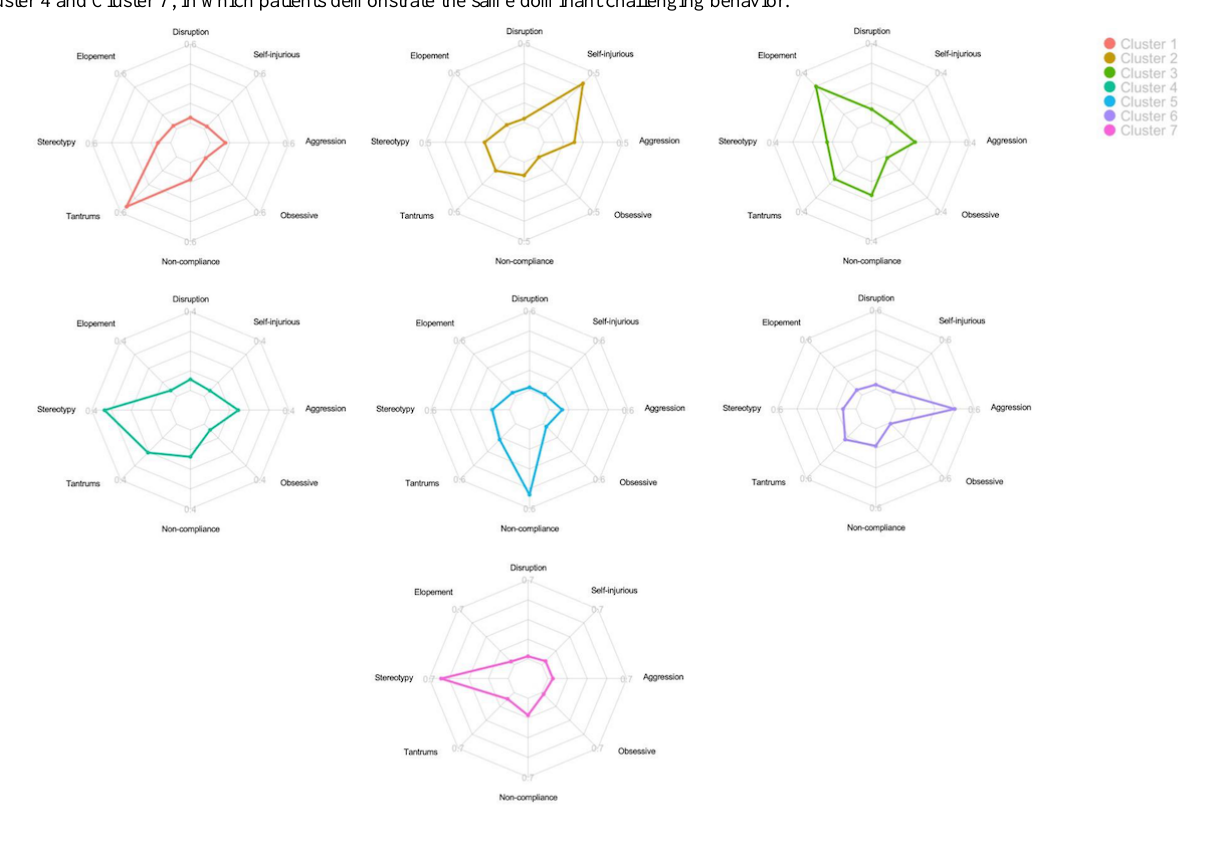
Figure 3. Radar graphs showing the dominant challenging behavior for each cluster. Note that the maximum varies between the clusters, particularly Cluster 4 and Cluster 7, in which patients demonstrate the same dominant challenging